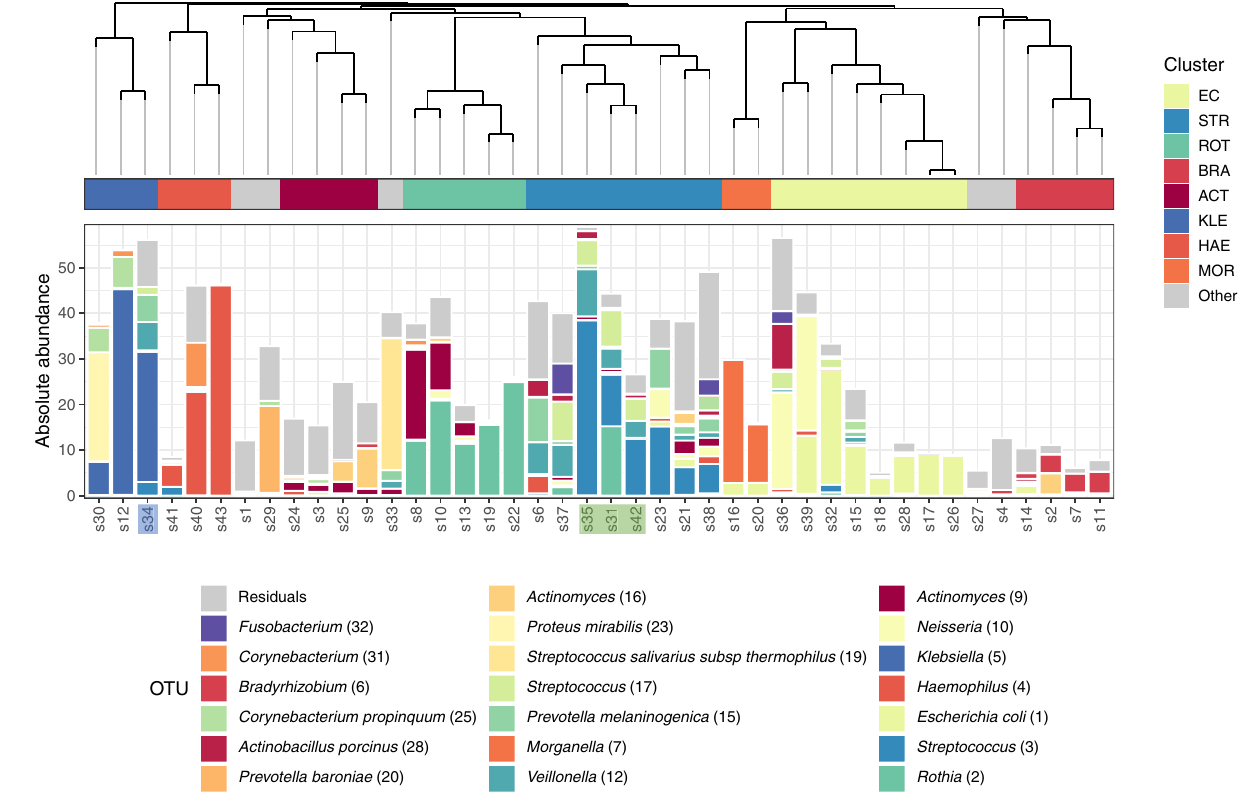
Figure 1. Respiratory bacterial communities in COVID19 patients. Dendrogram visualizing a hierarchical clustering of samples. Stacked bar charts show the absolute abundance of the 20 highest-ranked OTUs and of residual bacteria. On the basis of clustering indices, an optimal number of 13 clusters was identified, 8 of which comprised more than one study samples. Classifier taxa for these eight clusters were: Escherichia coli (EC), samples are tracheal aspirates except for s31, s35 and s42 that are sputum (highlighted in green) and s34 that is bronchoalveolar lavage (highlighted in